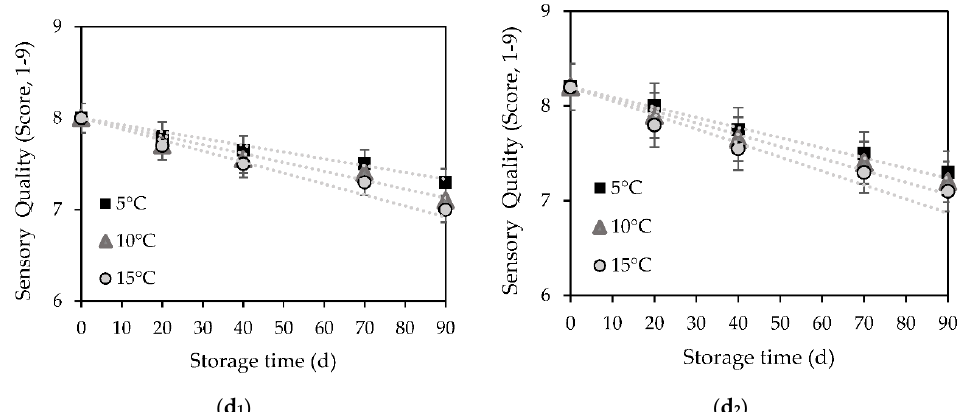
Figure 2. ( a ) Total color change ( Δ Ε ) by instrumentally measured color parameters L , a , and b , ( b ) texture measured as maximum force (hardness, F max , N), ( c ) scores for total sensory quality (scale 1– 9), and ( d )% vitamin C loss of pumpkin cuts in solution of strained yoghurt whey or water (Index 1: OD SY Whey and Index 2: OD Water ). Experimental points correspond to isothermal temperature conditions ( ) 5 °C, ( ) 10 °C, ( ) 15 °C; lines represent the respective model fit. Table 3. Estimated kinetic parameters ( k color , k texture , k vitaminC , k sensory ; E a , k ref at T ref = 4 °C) used for quality deterioration of OD processed pumpkin cuts at 55 °C for 120 min (OD SY Whey and OD Water ), and stored at isothermal temperature (5, 10, 15 °C) conditions based on instrumental measurement of color and texture, vitamin C, and organoleptically perceived quality (sensory).